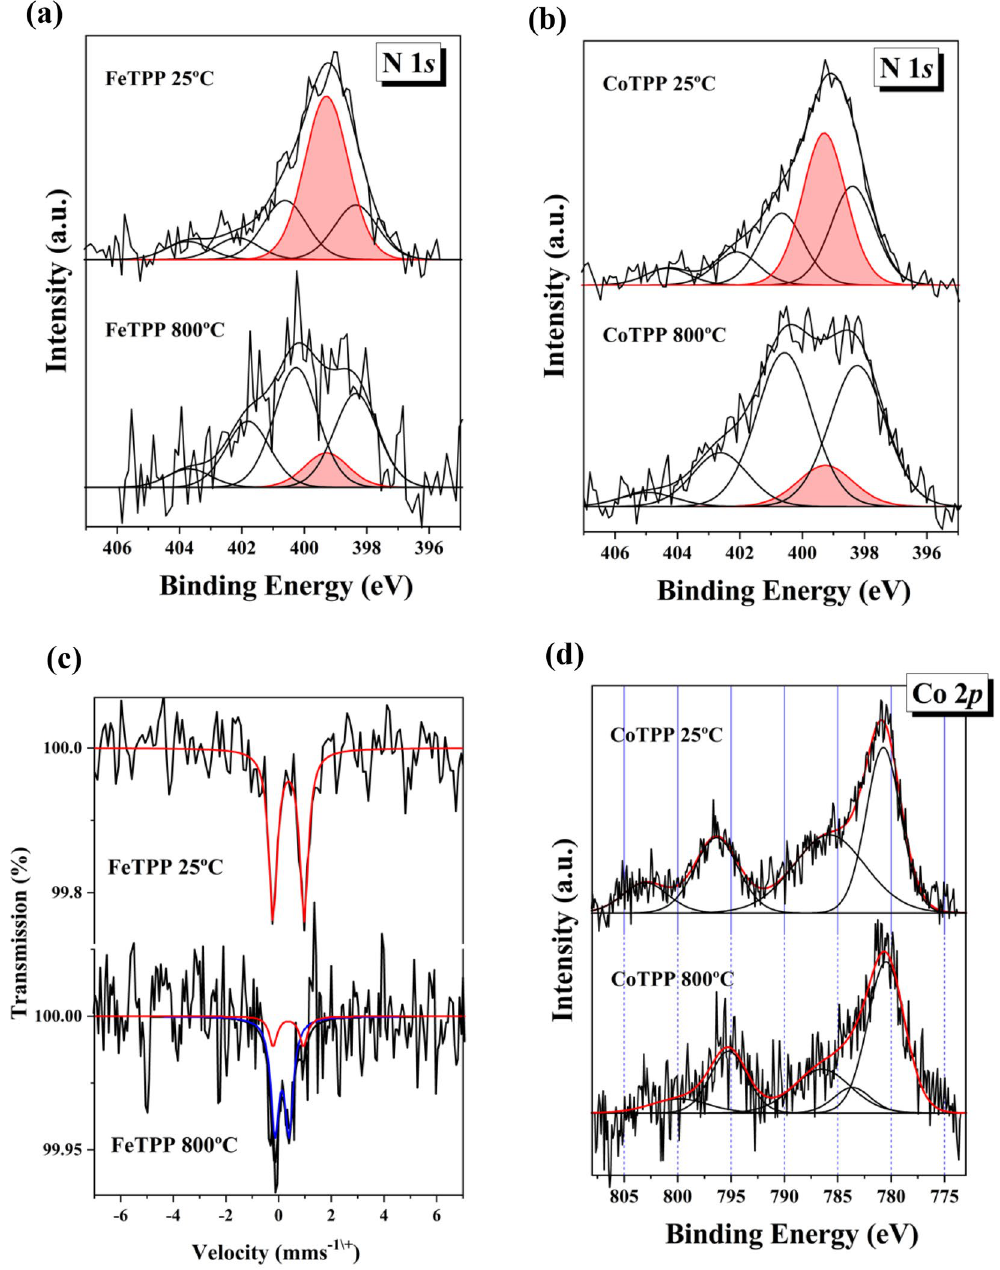
Figure 3. ( a , b ) N1s XPS spectra recorded from the FeTTP and CoTPP materials adsorbed on Vulcan XC-72 before and after pyrolysis; ( c ) room temperature 57 Fe Mossbauer spectra recorded from the FeTPP materials; ( d ) Co 2p XPS spectra recorded from the CoTPP